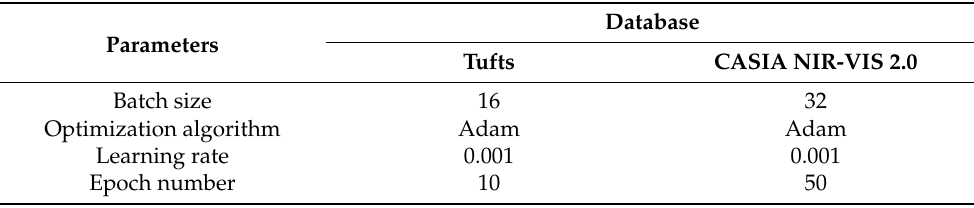
Table 1. Parameters used in the training procedure for each multispectral